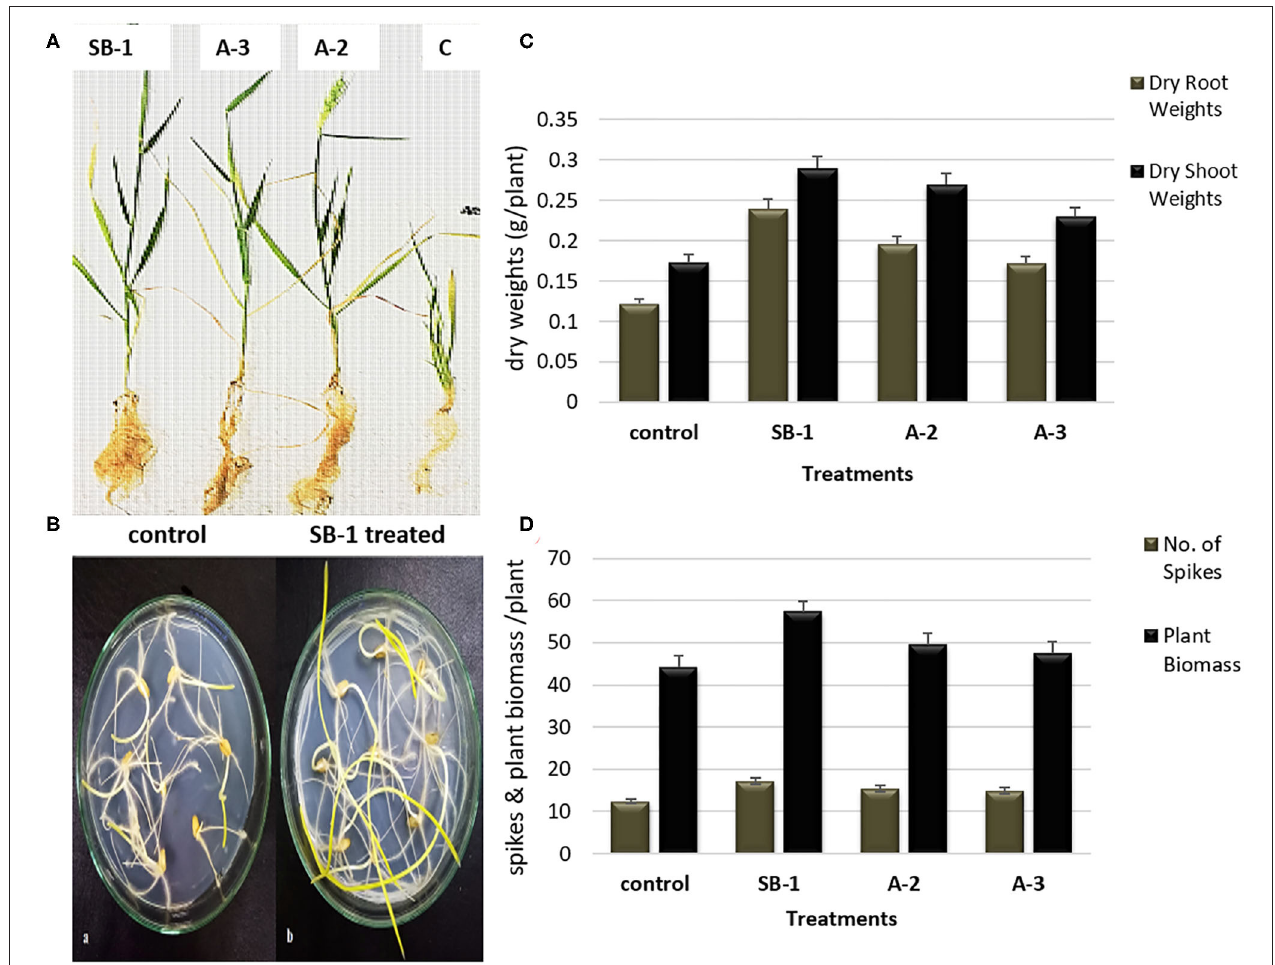
FIGURE 5 | Effect of Bacillus spp. inoculation on shoots and roots growth (A) , comparison of un-inoculated control and B. amyloliquefaciens SB-1 treated seedlings in 1% water-agar plates (B) , effect of Bacillus spp. inoculation on dry weight of shoot and root (C) , and plant biomass, and number of spikes of wheat plants (D)